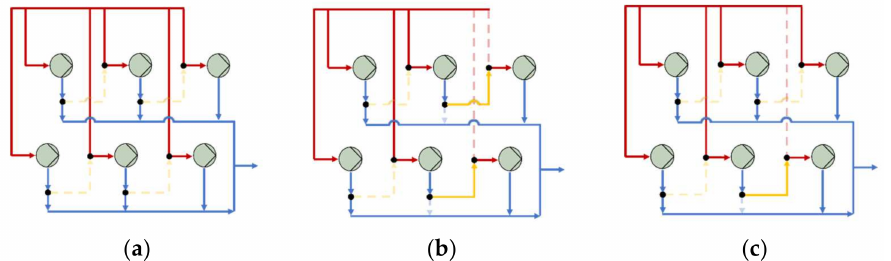
Figure 5. Installation layout according to the different scenarios: ( a ) All the heat pumps connected in series; ( b ) Four heat pumps connected in parallel, two in series; ( c ) Five heat pumps connected in parallel, one in series. Note that the dashed lines indicate existing connection but not used in the scenario. The yellow lines indicate the outlet flow from a heat pump which is used as inlet for another (serial